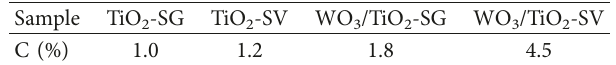
Table 5: The amount of carbon elemental compositions (wt.%) on external surface supports and catalysts after reaction obtained from EDX (the spent catalyst used in the reaction condition at T 200–400 ° C for (cid:28)